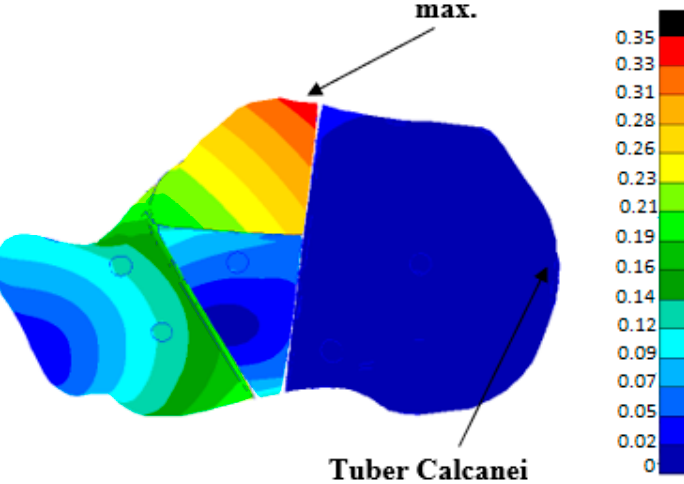
Figure 19. Total displacements on the broken heel bone/mm/after C-NAIL application.